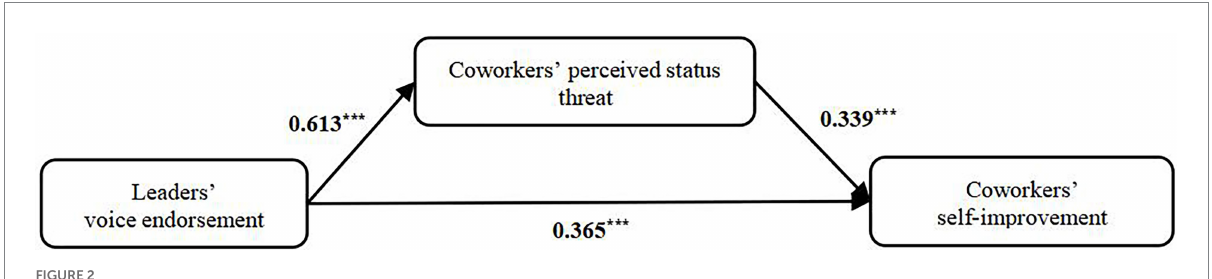
FIGURE 2 Results of path analysis. N = 279, ** p < 0.01, *** p < 0.001.